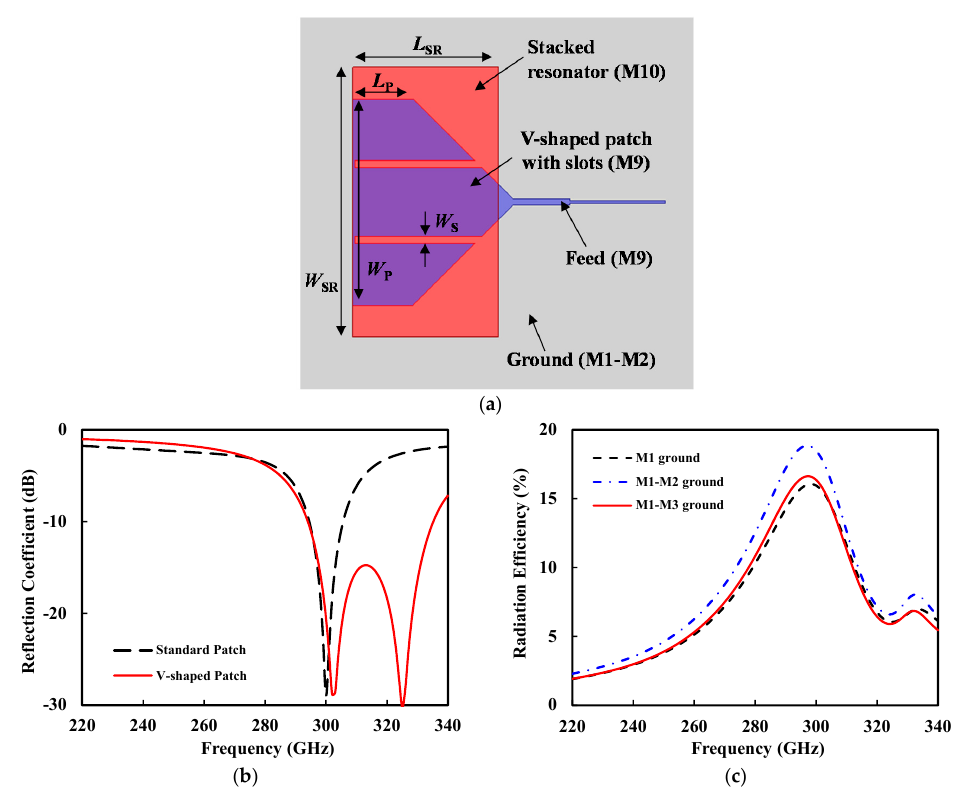
Figure 4. ( a ) Top view of the proposed V -shaped patch antenna ( W P = 325 μ m, L P = 95 μ m, W S = 10 μ m, W SR = 425 μ m, L SR = 230 μ m, feed width/length = 9 μ m/90 μ m, 50 Ω -line width = 4 μ m). ( b ) Simulated reflection coefficient (| S 11 |). ( c ) Simulated efficiency according to the metal layer composition of the ground plane.